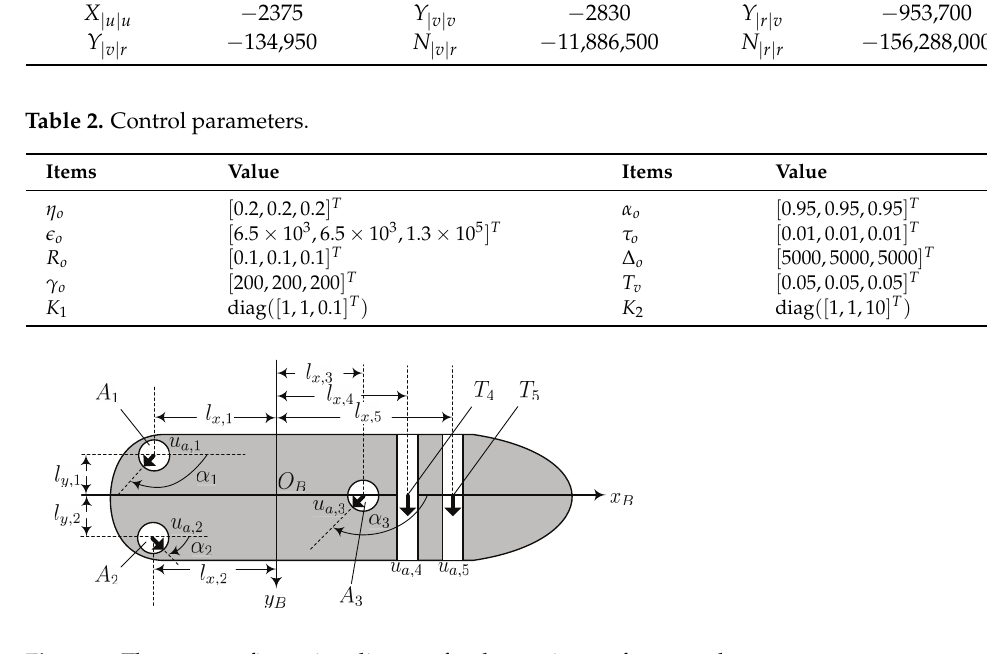
Figure 2. Thruster configuration diagram for the marine surface